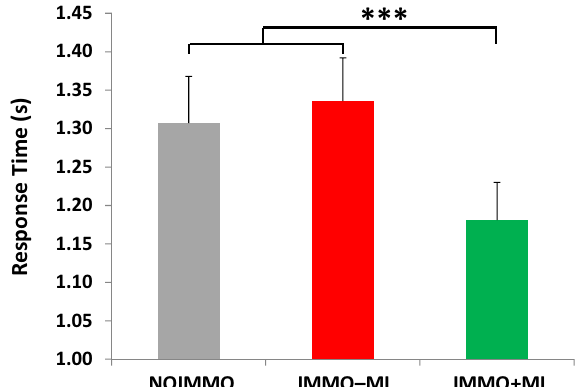
Figure 2. Response times during the hand laterality judgment task. Independently of hand laterality, response times after the IMMO+MI condition was significantly faster compared to NOIMMO and IMMO−MI conditions. Error bars indicate the standard error of the mean. *** p <